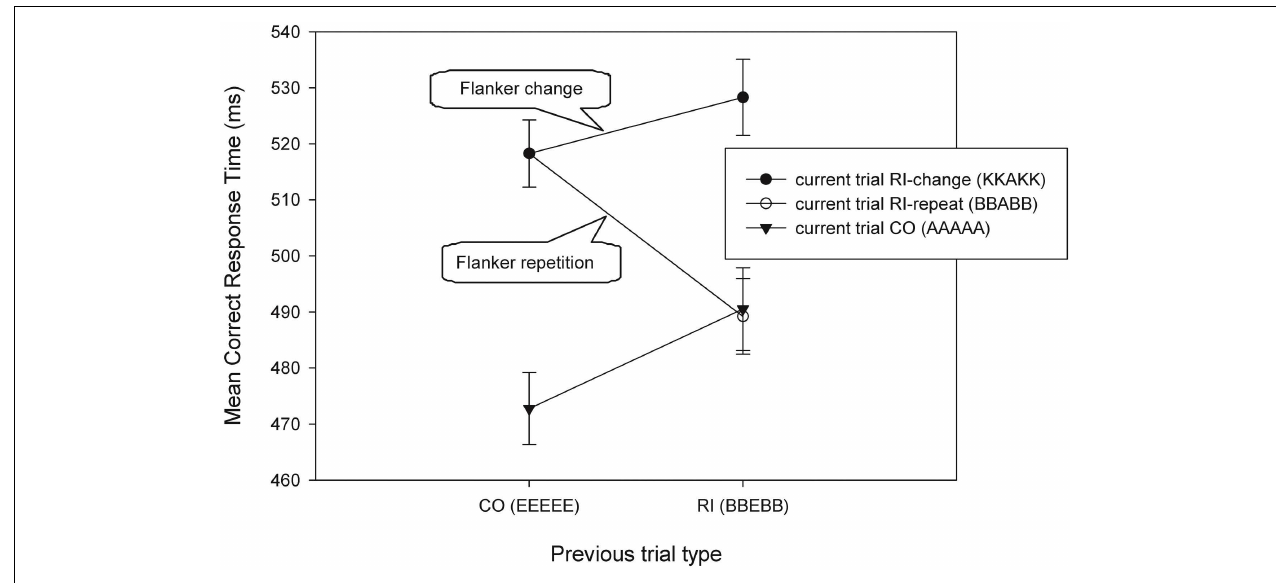
flanker repetition (BBEBB followed by BBABB) and trials that have not (BBEBB followed by KKAKK). Examples of previous and current trials are presented in brackets. CO: congruent; RI: